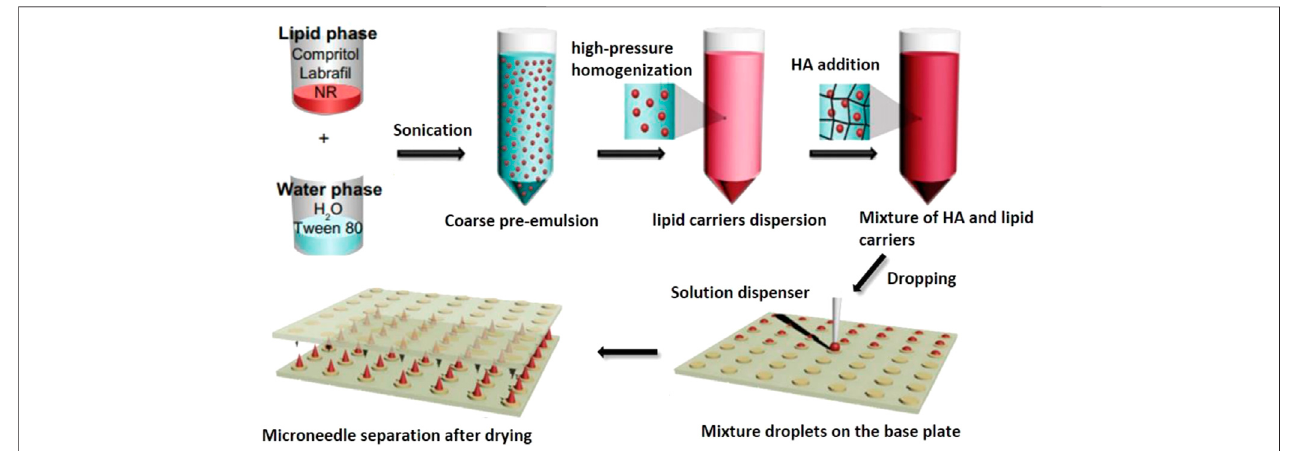
FIGURE 4 | The schematic graph of the synthesis of HA MNs containing lipophilic NR-loaded lipid nanoparticles. Abbreviation: HA (hyaluronic acid), NR (Nile red), NLCs (nanostructured lipid carrier) (Lee et al., 2014).